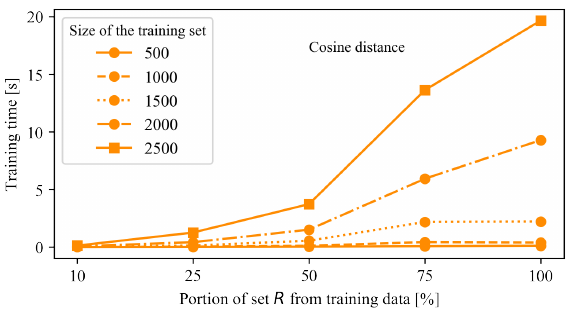
Figure 11. Area under curve value of the MLM using L2-norm with cosine distance (left) and Euclidean distance (right) varying size of the training set and proportion subset R .